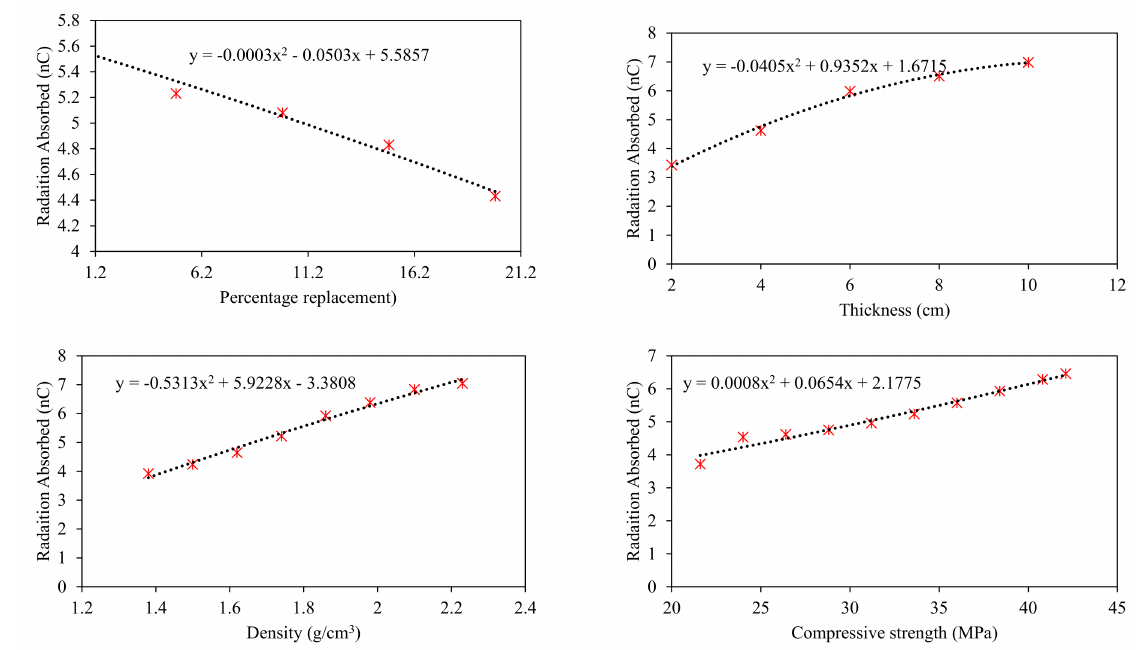
Figure 11. Parametric analysis of ANN model for Type 4